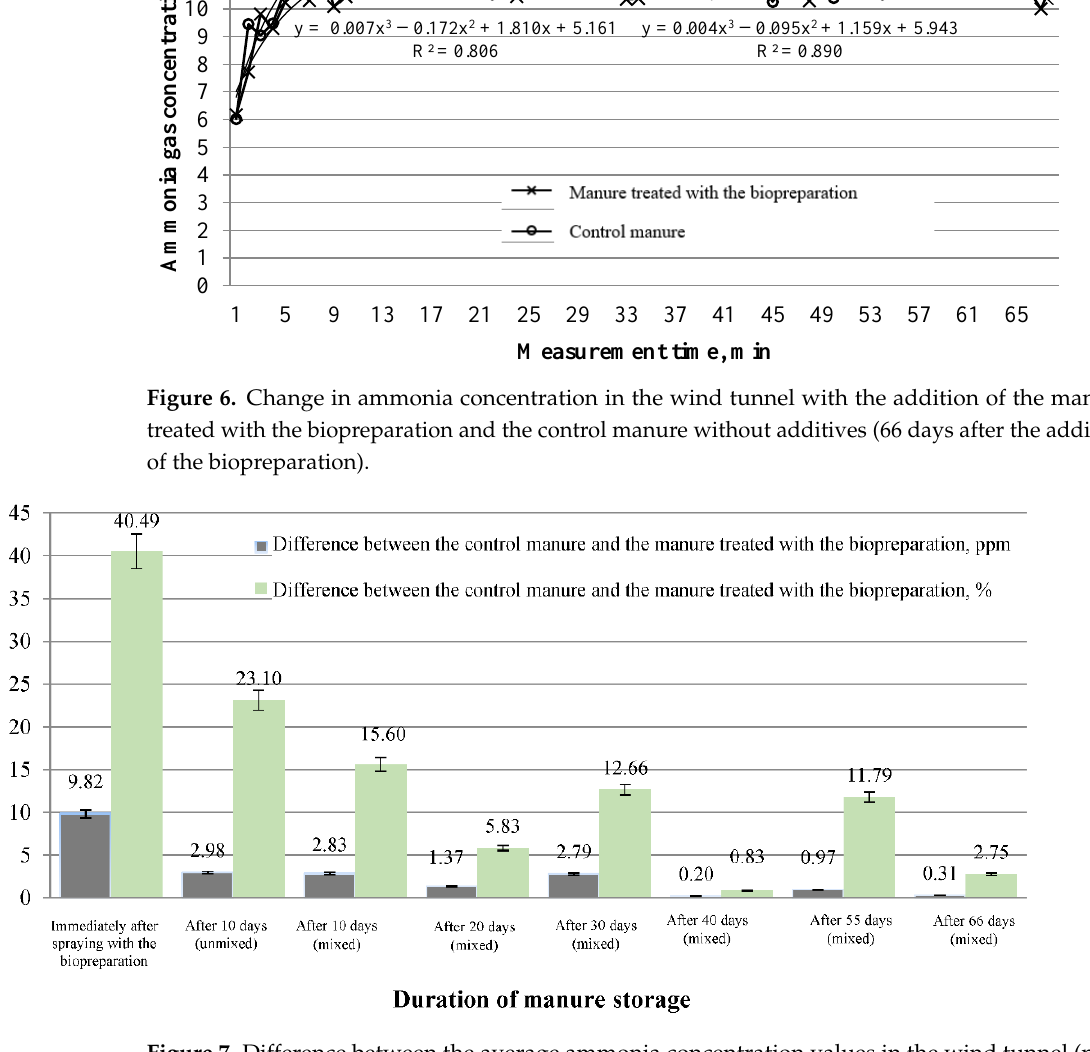
Figure 7. Difference between the average ammonia concentration values in the wind tunnel (ppm and %) after the addition of the control manure without additives and the manure treated with the biopreparation in the tunnel, depending on manure storage time 35.